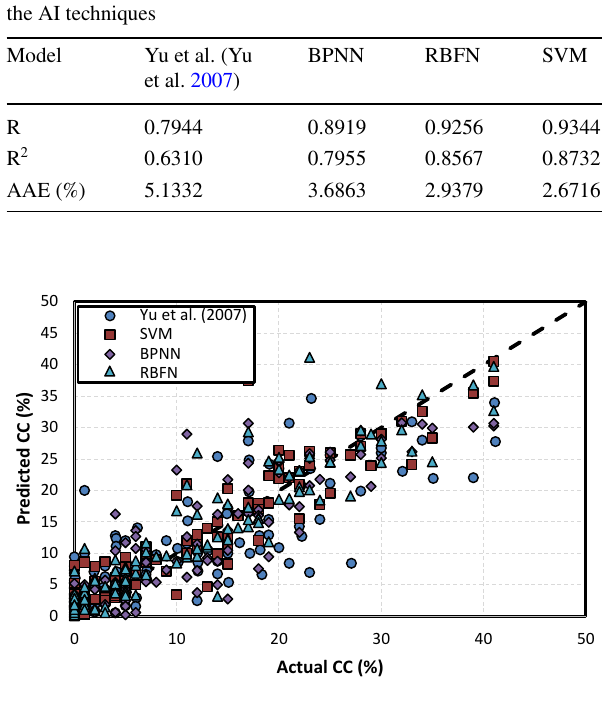
Fig. 17 Comparison of results between the empirical correlation and the AI